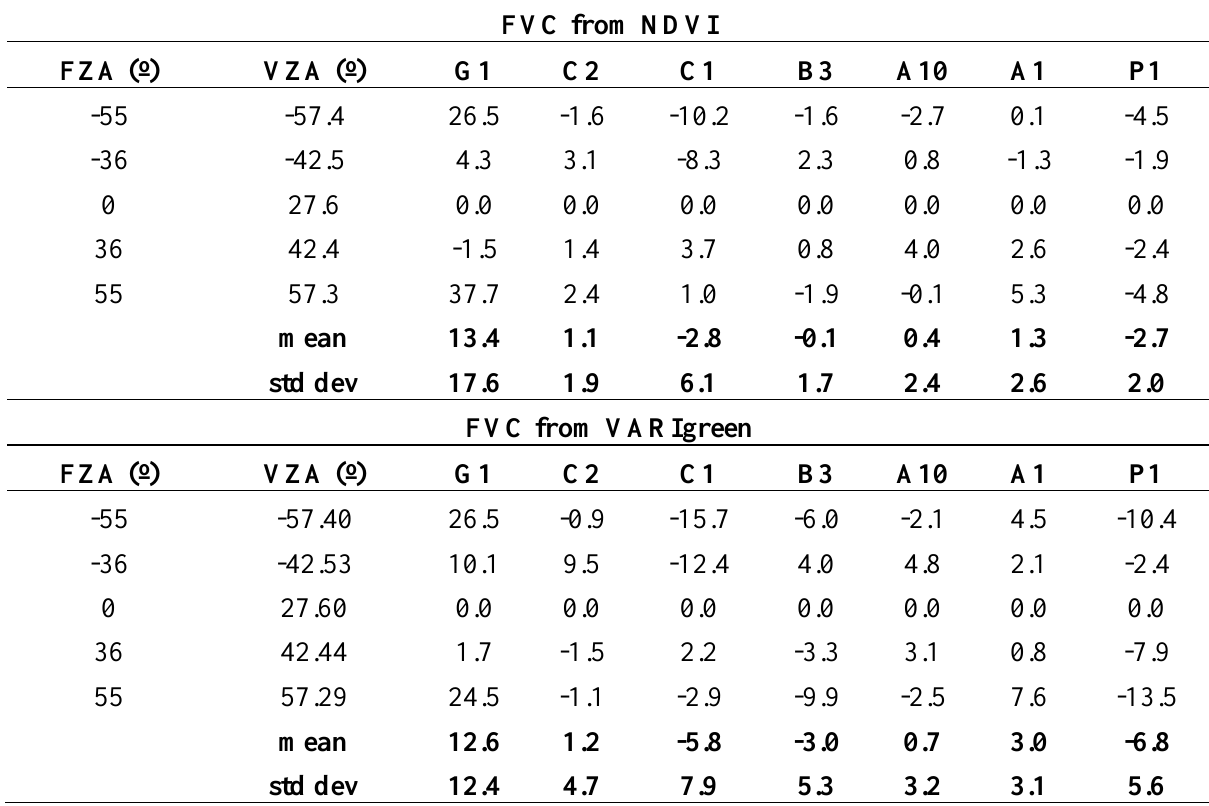
Table 5. Percentage (in %) of Fractional Vegetation Cover (FVC) angular variations (value at certain view angle minus value at nadir divided by the value at nadir) for the different plots. Mean and standard deviation (std dev) values are also